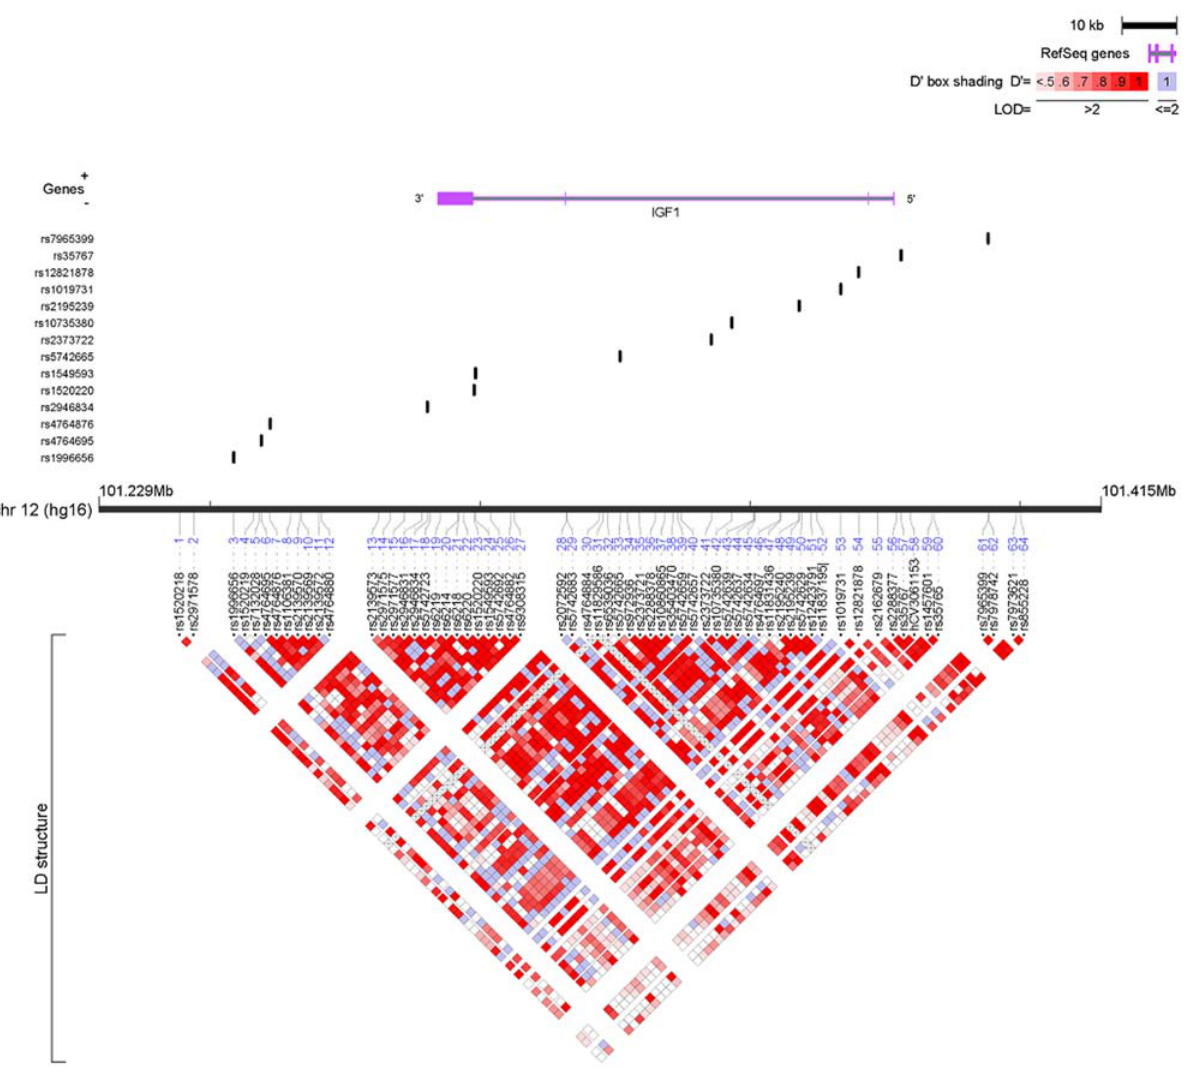
Figure 1. IGF1 SNPs and linkage disequilibrium. 64 SNPs were identified covering a 56-kb region. Of these, 14 htSNPs defined the common haplotypes among Caucasians.